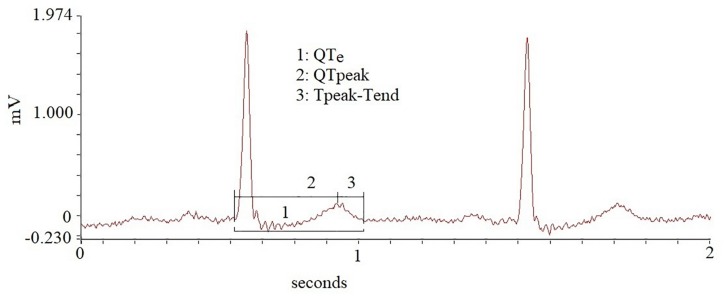
Different repolarization intervals obtained in the study.